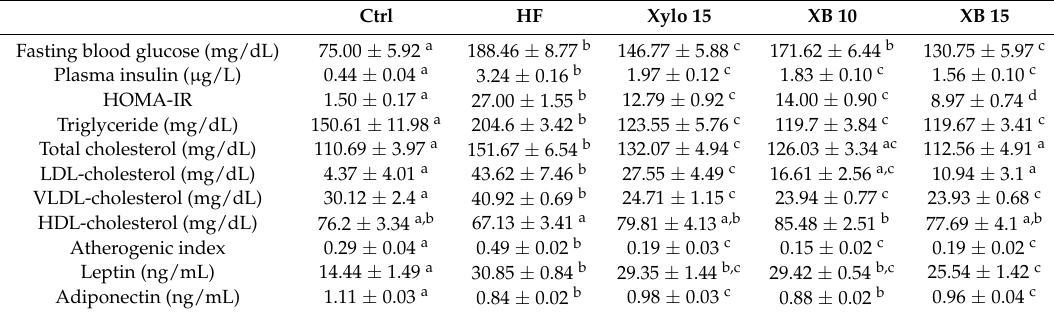
Table 2. Blood glucose, plasma lipid profiles, and atherogenic index of mice fed with different diets for 10 weeks 1 .